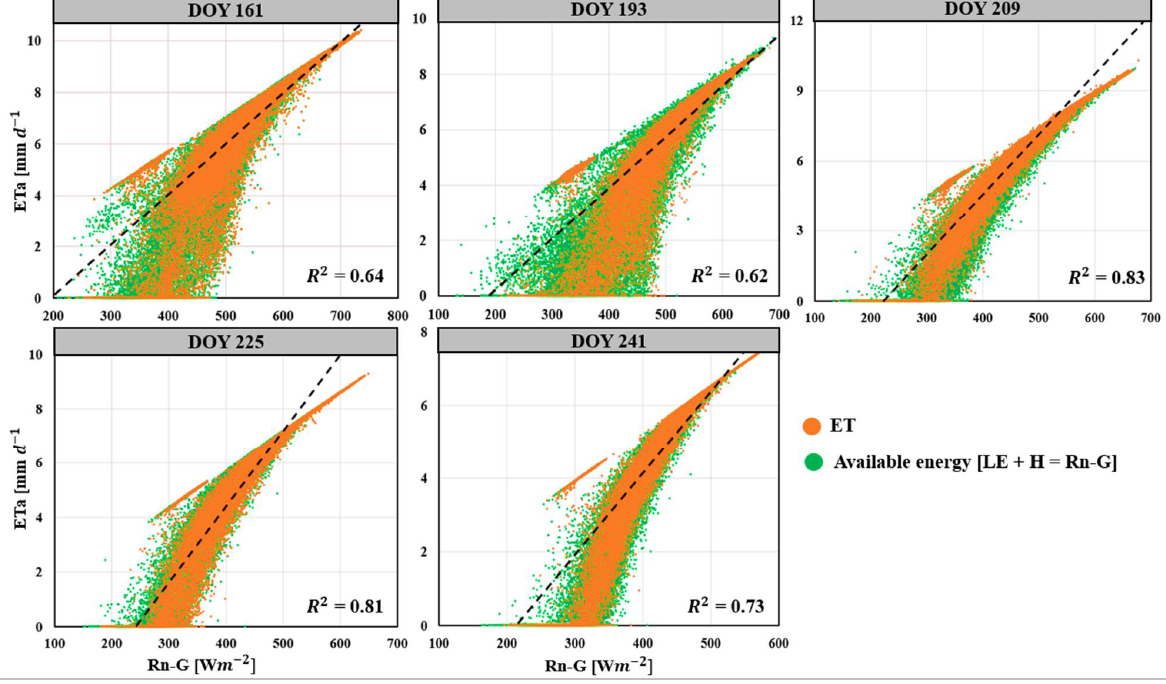
Figure 13. Nexus between available energy and ETa over Yanqi during the summer season 2019, Day of the Year (DOY). (The black dotted line indicates a reasonable agreement based on the fitting linear model while the orange dots represent the evapotranspiration-ETa and green representing the available energy Rn-G).